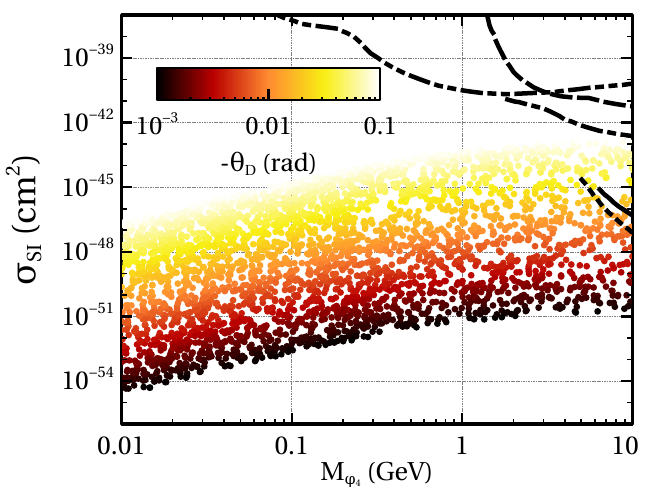
Figure 9 . Spin independent scattering cross sections with exclusion limits on σ SI from various ongoing as well as future